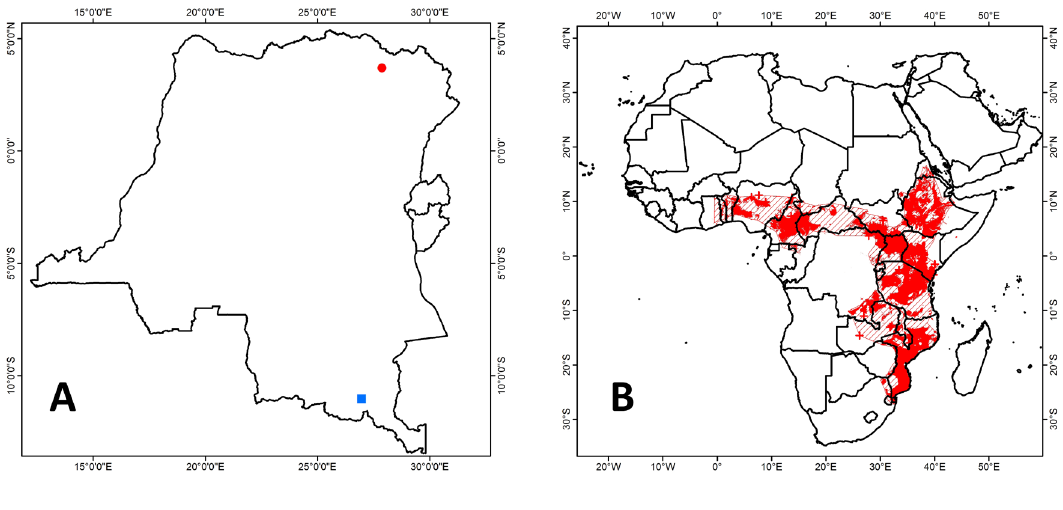
Fig. 48. Distribution maps. Scotoecus hindei Thomas, 1901. A . Distribution in the CRB area. B . Pan- African